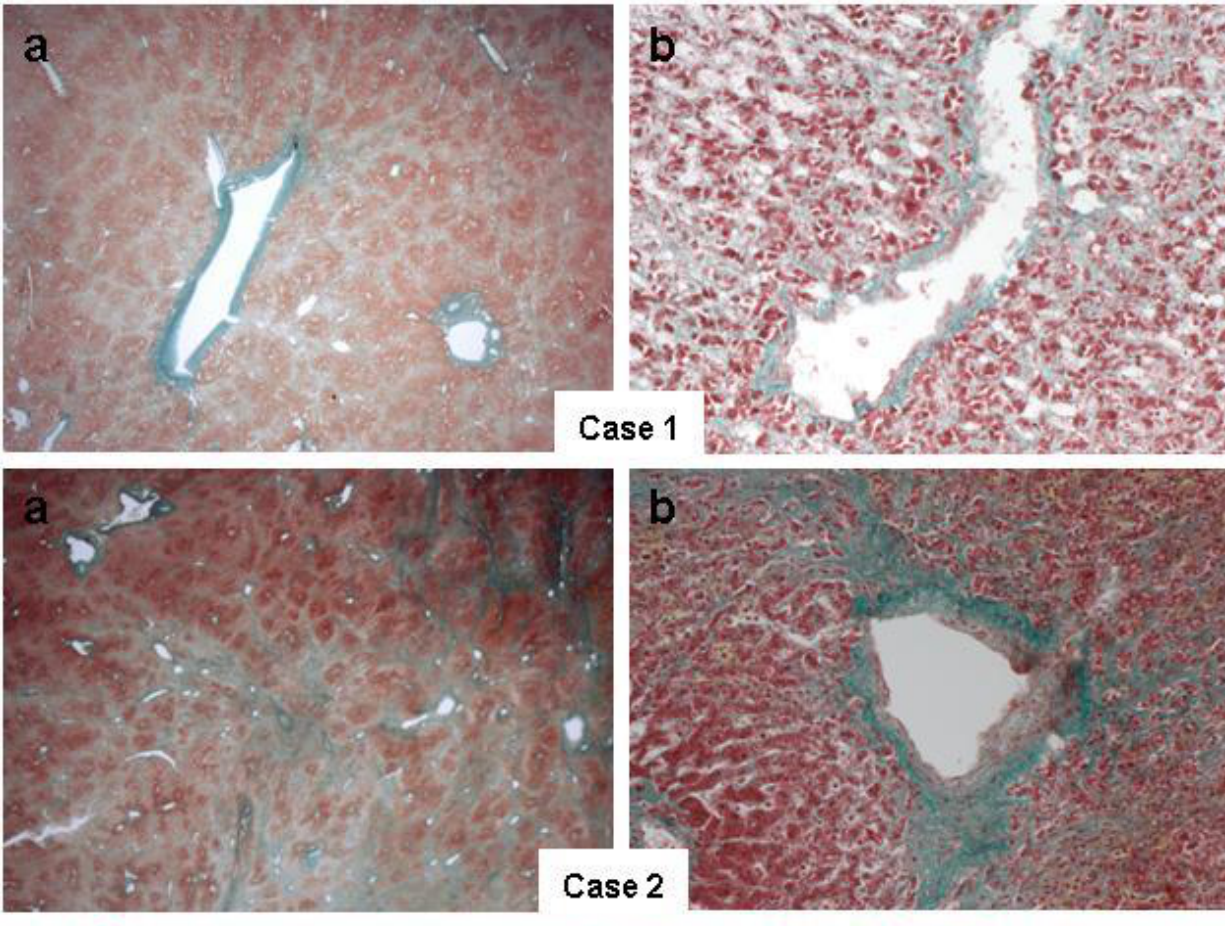
Figure 1. Liver histopathology obtained at autoptic examination by Masson’s Trichromic staining: ( a ) a panoramic view (×10 magnification) and ( b ) close up view (×40 magnification). In particular, the marked distortion of the liver structure, with fibrotic bridges arising from centrilobular veins and involving sinusoidal spaces and portal tracts, can be seen. Note the increasing thickness of fi- brotic septa from Cases 1 to 4, so as to manifest the characteristic condition of “reverse cirrhosis”; moreover, in Case 4, the presence of cholestasis also resembles the so called “nutmeg pattern”.